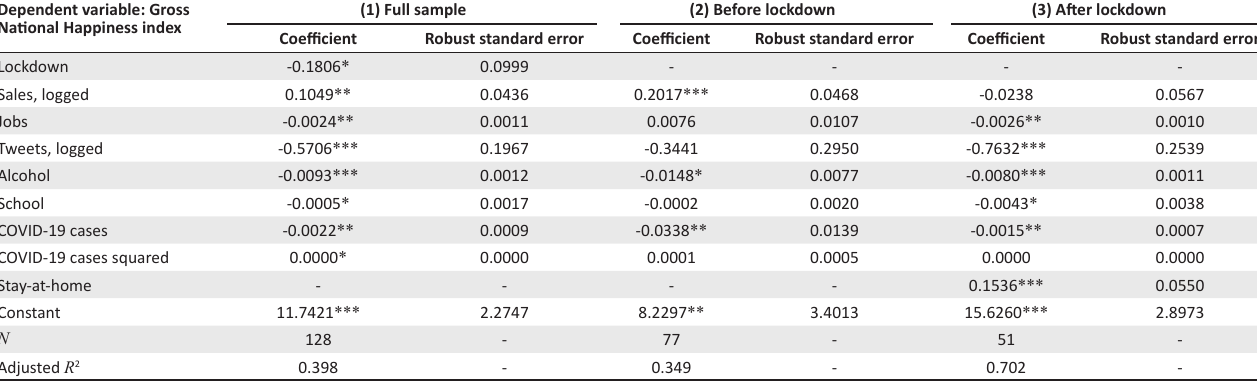
FIG URE 2: Emotions of South Africans before and after TABLE 2: Ordinary least squares estimation results of the relationship between different covariates and happiness. Dependent variable: Gross National Happiness index